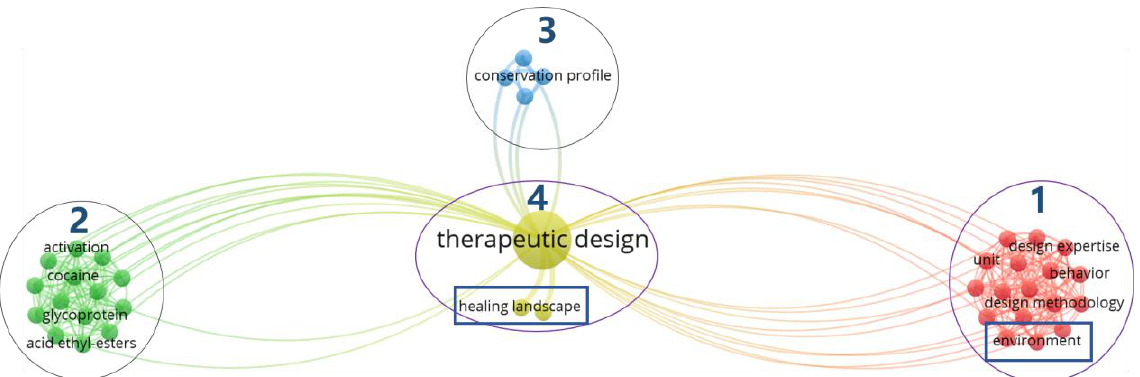
Figure 5. Network visualization map with the theme of therapeutic design (TD) in the WoS core collection database via VOSviewer (devised by the authors).